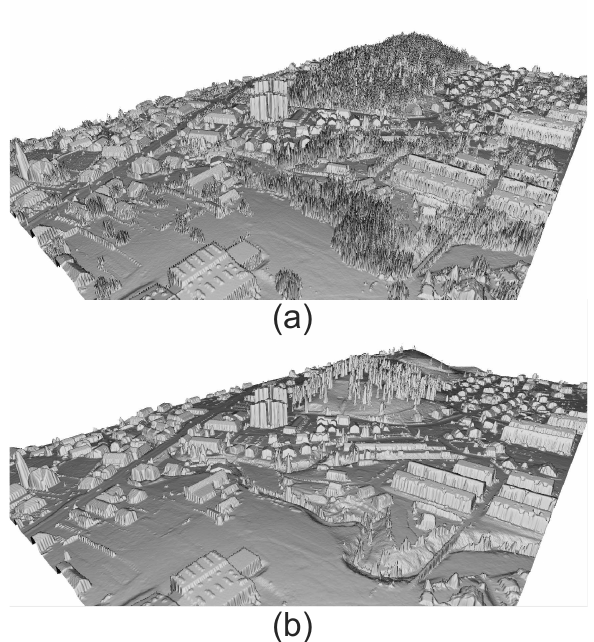
Figure 1: Denoising of (a) LiDAR data generated grid, where (b) a majority of the vegetation is